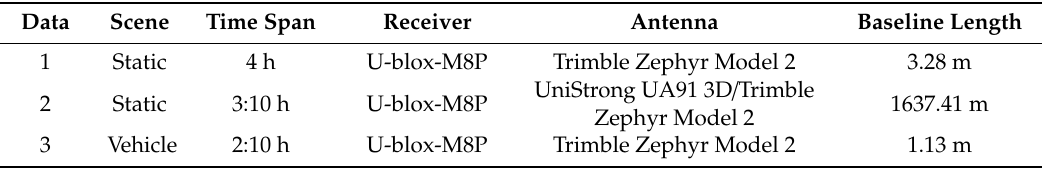
Table 2. Basic processing configuration.